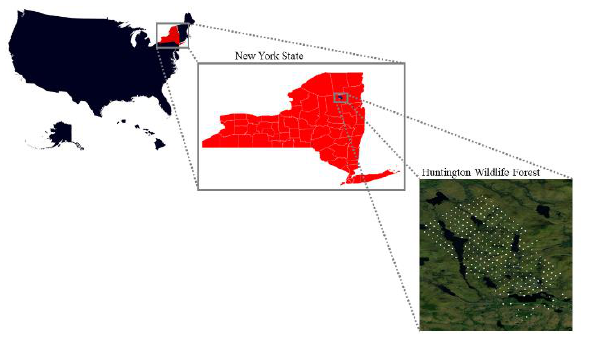
Figure 1 . Location of the study area (Essex County, NY) for forest AGB estimation using ensemble machine learning models. White circles depict sample plots located in Huntington wildlife